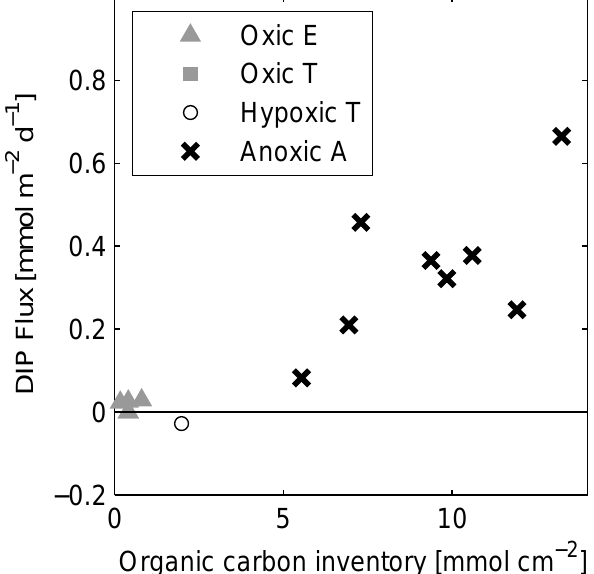
Fig. 10. DIP flux versus DIC flux. Fluxes are presented as mean values for each lander deployment.